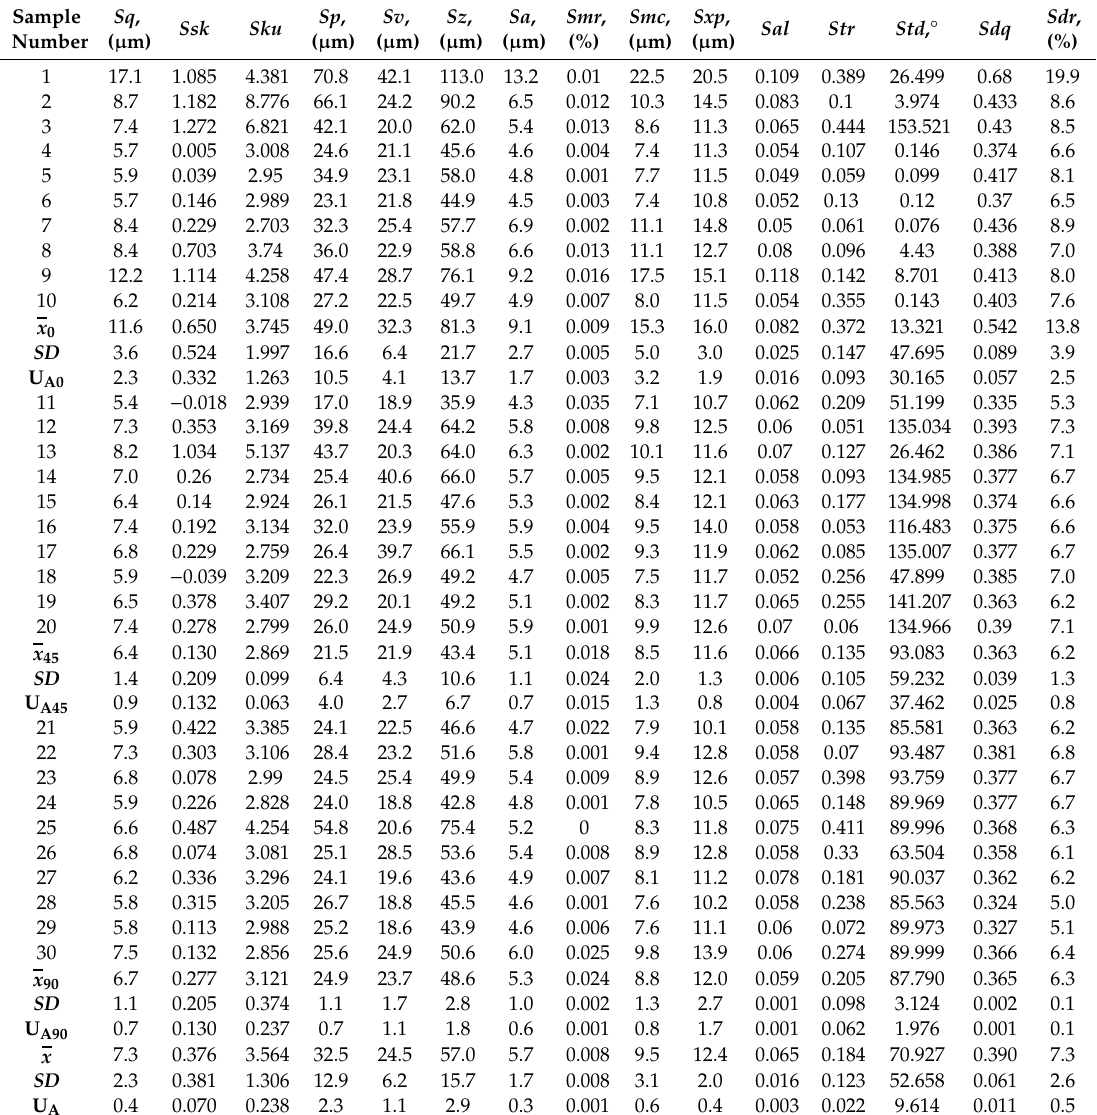
Table 4. Value of the 3D surface roughness